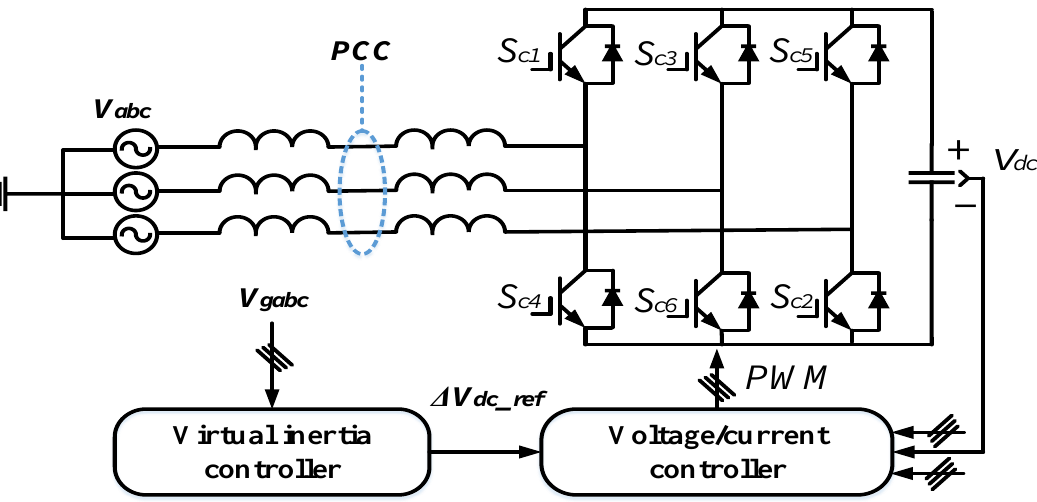
Figure 15. Schematic diagram of VSG [100].